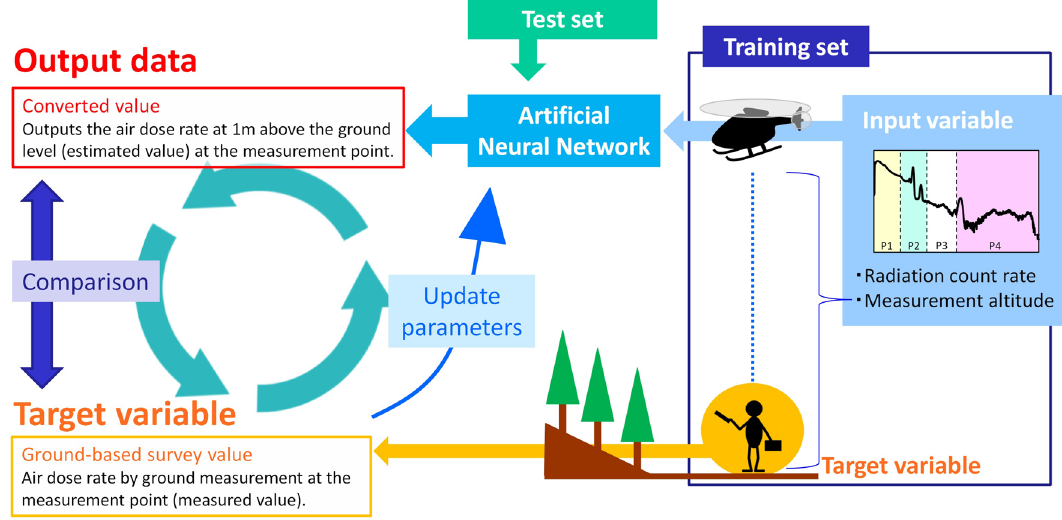
Figure 1. Images of the application of the artificial neural network to the airborne radiation